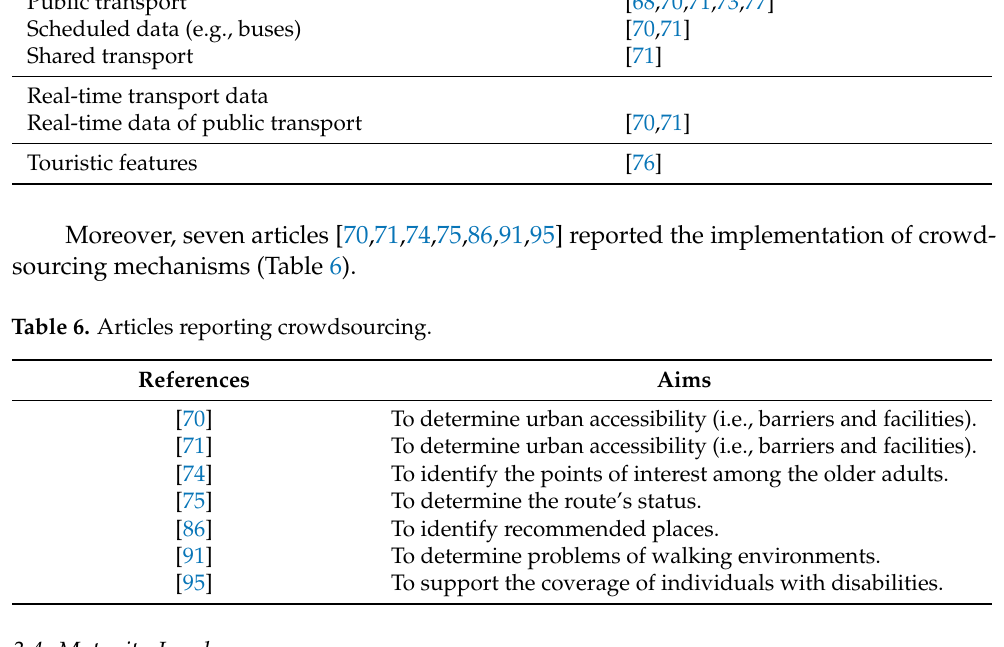
Table 6. Articles reporting c rowdsourcing.